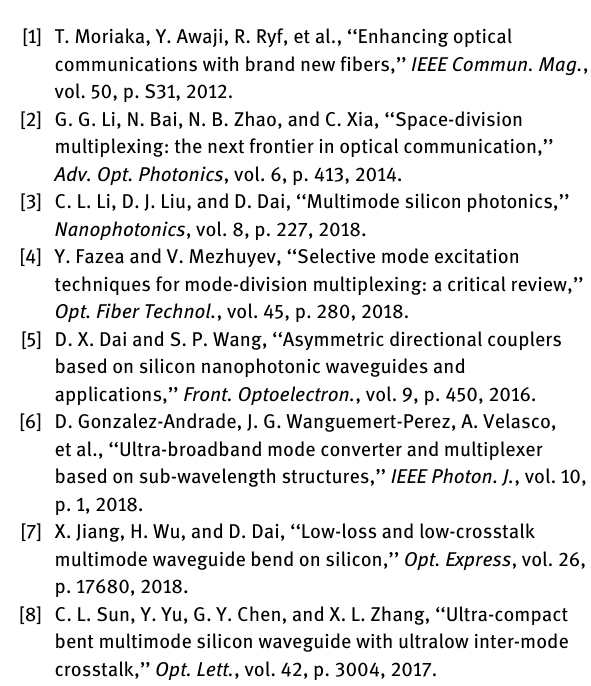
Figure 15: Measured BER performance (a) and the corresponding constellations of QPSK (b) of the WDM dropping transmis- sions and back-to-back transmission for two adjacent wavelength-channels C